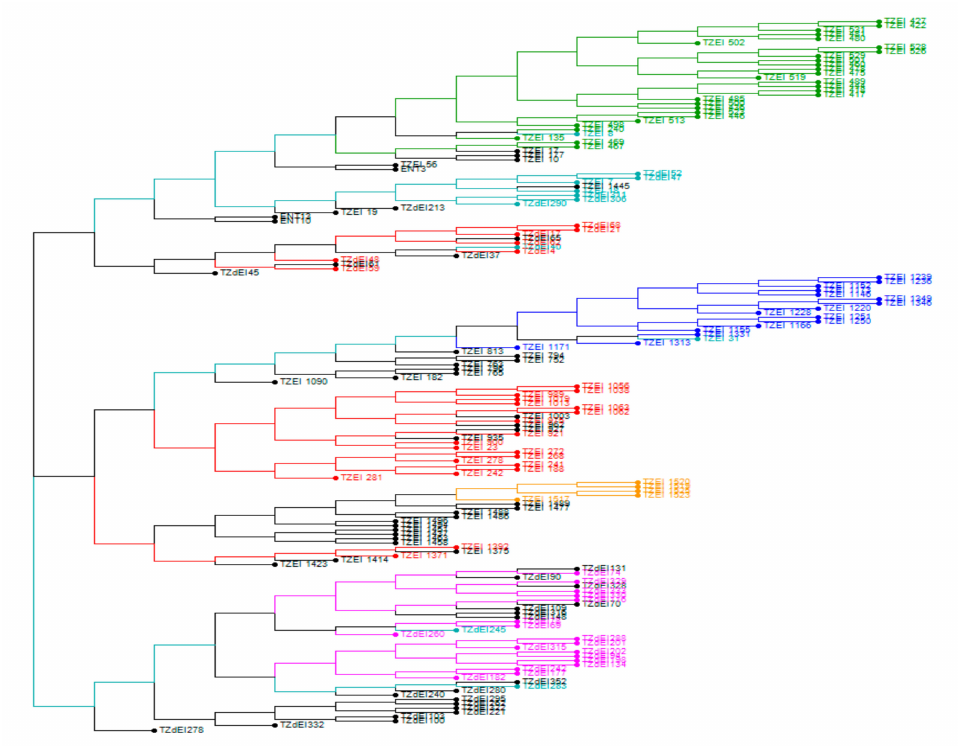
Figure 5. Clustering of 162 yellow and white early tropical maize inbred lines based on 9684 DArT SNP markers (red (cluster 1), green (cluster 2), blue (cluster 3), yellow (cluster 4), pink (cluster 5), teal (cluster 6) and black